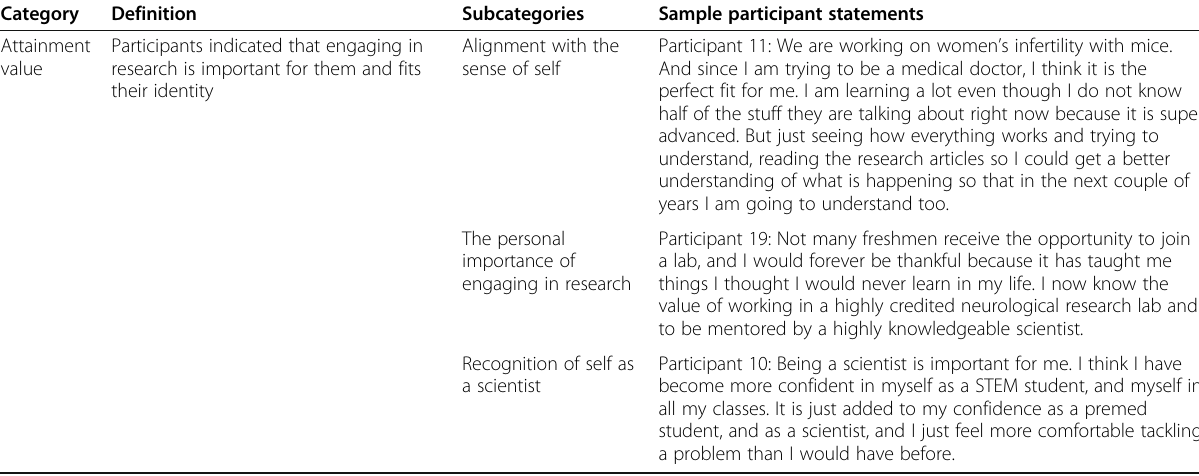
Table 1 Attainment value definition, subcategories, and examples of participants ’ statements